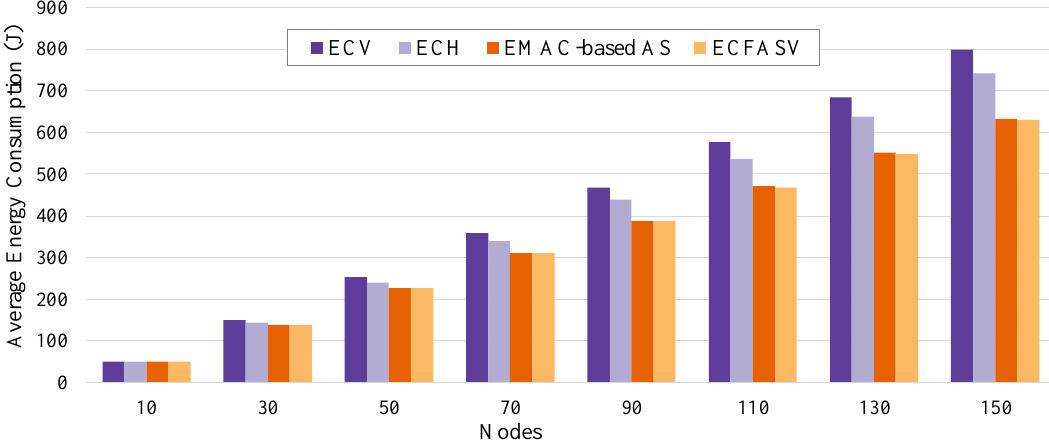
Figure 18. Total energy consumption until all the nodes connect to the network for a scenario where the PAN coordinator has unlimited power